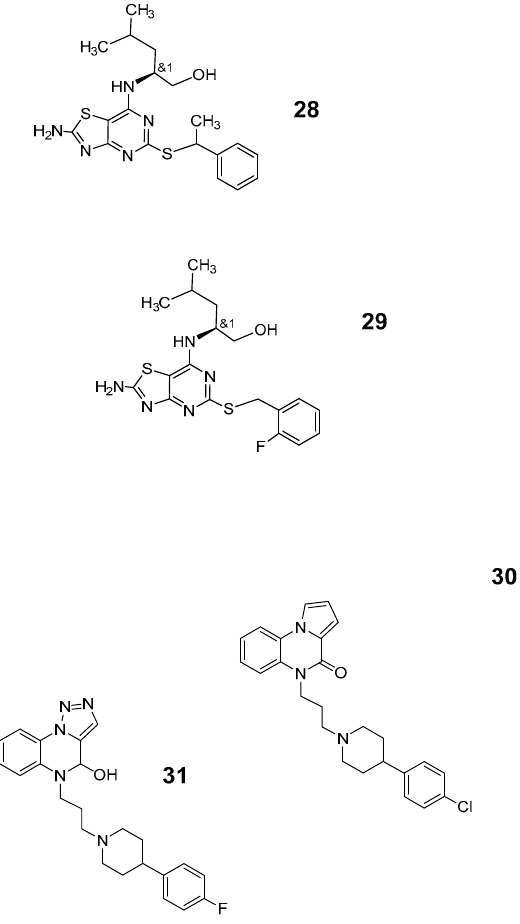
Figure 7. Antagonists of CX3CR1 and allosteric modulators: 28 : AZD8797; 29 : FBTTP; 30 : JMS-17-2; 31 : modified JMS-17-2. (For IUPAC names of all compounds according to ChemDraw19.0 see Appendix A.)